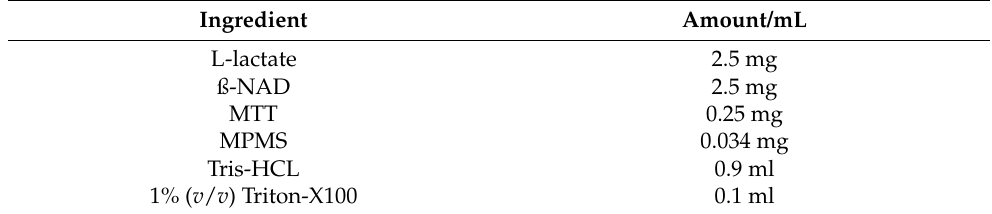
Table 1. The amount of each ingredient required for preparing 1 mL of the LDH substrate